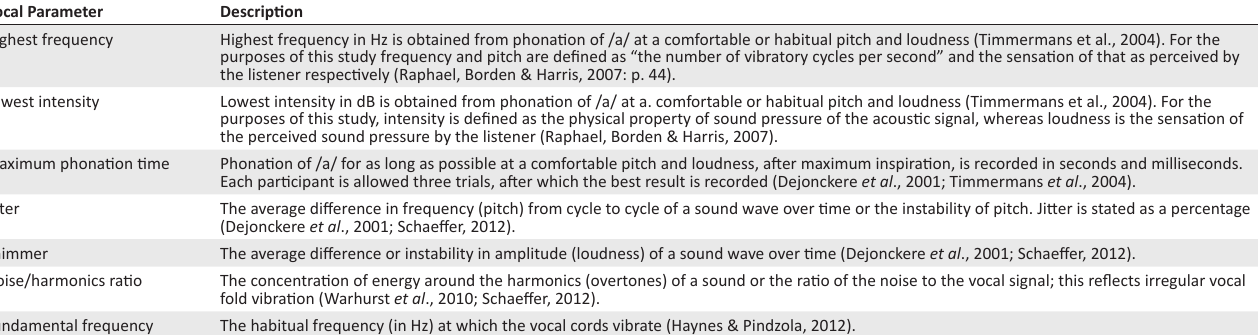
TABLE 3: Vocal parameters measured. Vocal